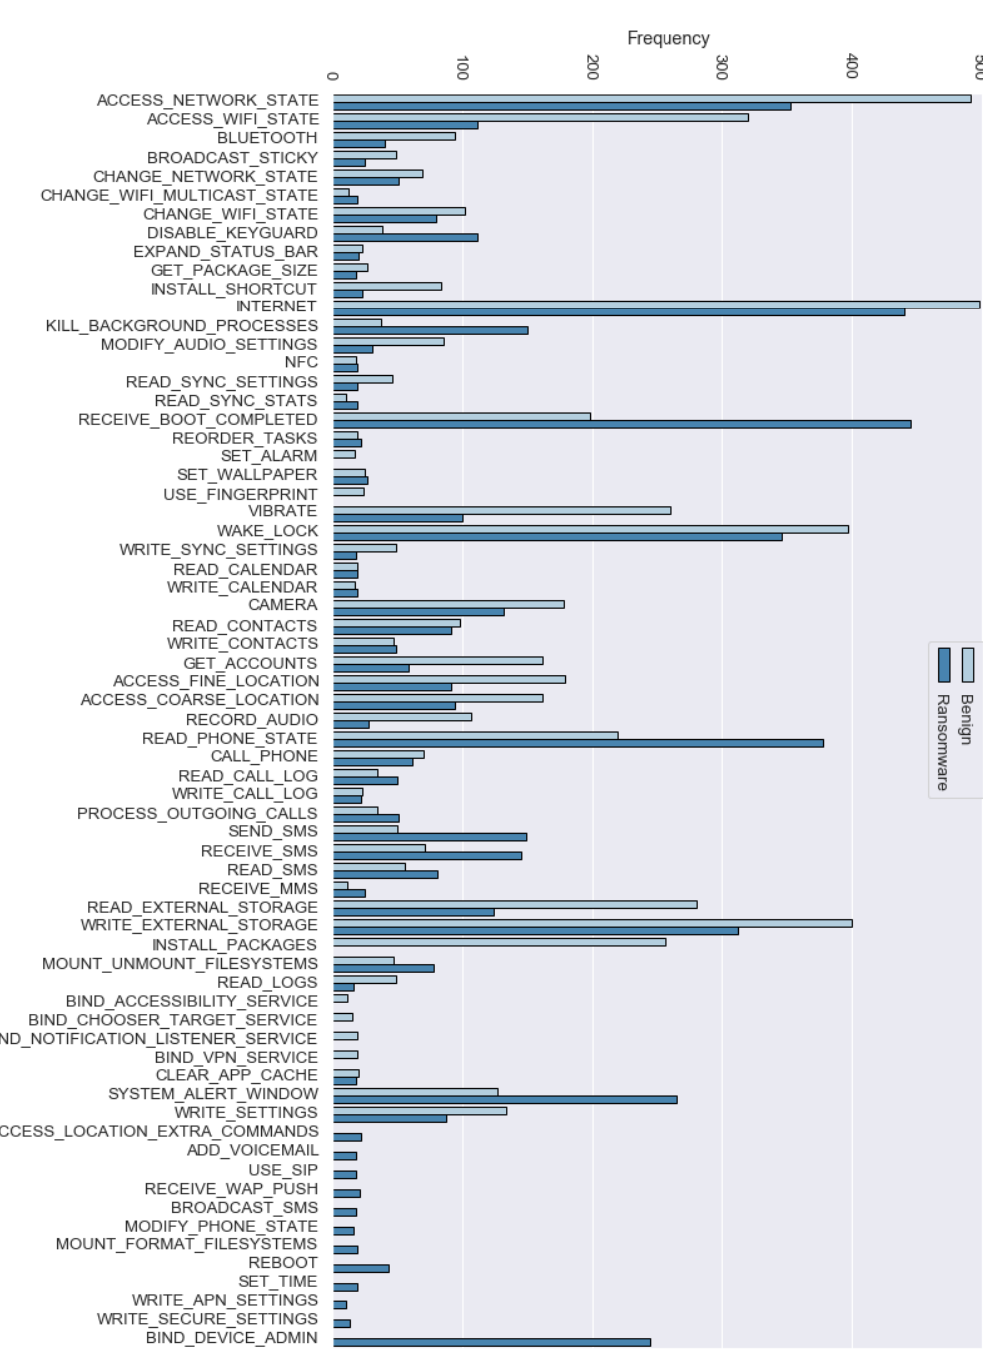
Figure 4. A bar chart depicts the permission features occurrences in the benign and ransomware classes. The features with less than 2% occurrences were